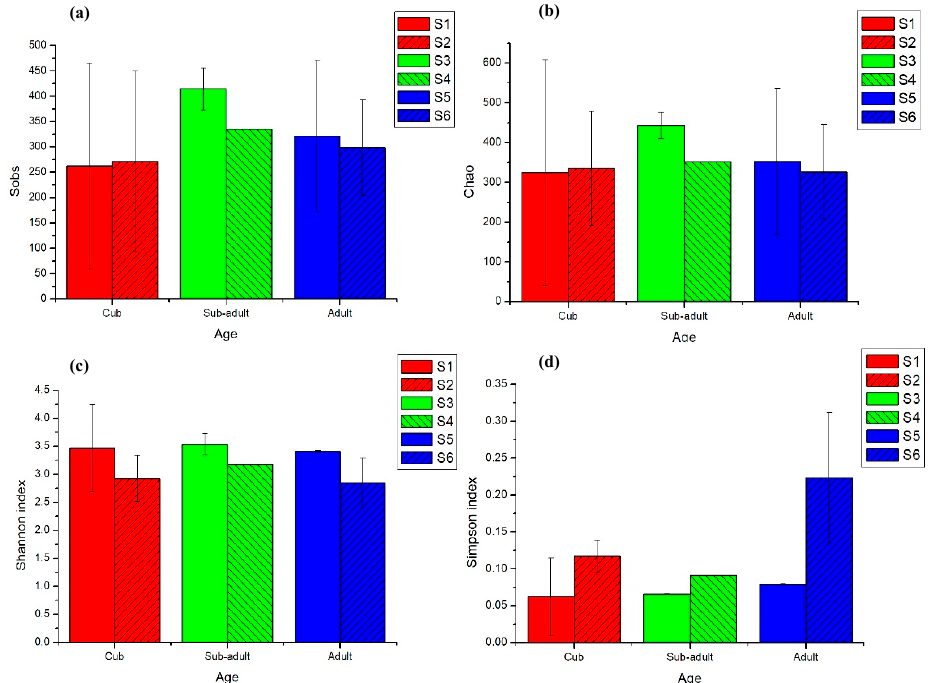
Figure 2. Intestinal fungal Alpha diversity index of giant pandas at different developmental stages, taking the average of two experimental results in Aug (2017) and Feb (2018) of each sample. ( a ) Sobs; ( b ) Chao; ( c ) Shannon’s diversity index; ( d ) Simpson’s diversity index.